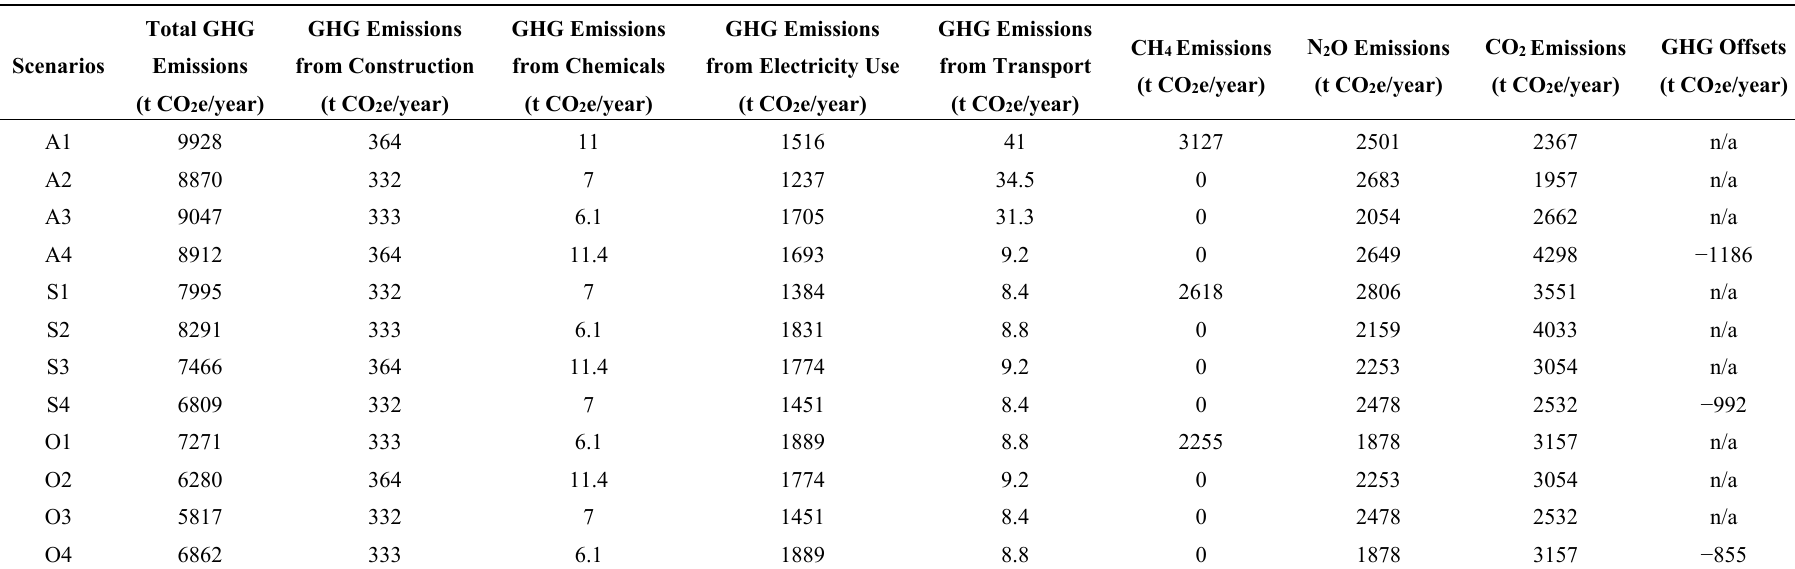
Table 3. Carbon footprints and GHG emissions from different sources for the twelve wastewater and sludge treatment